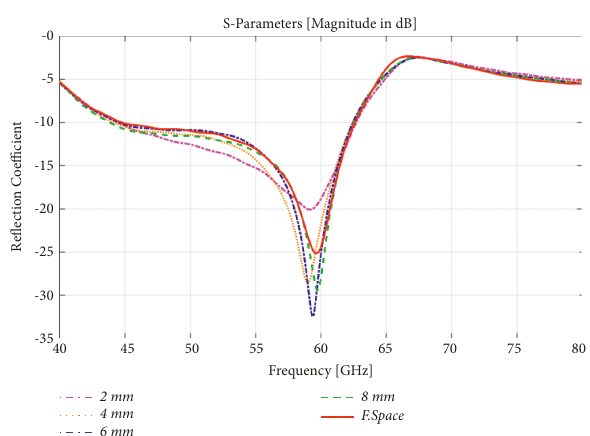
Figure 36: Return loss comparison of the single-element antenna for different distances.